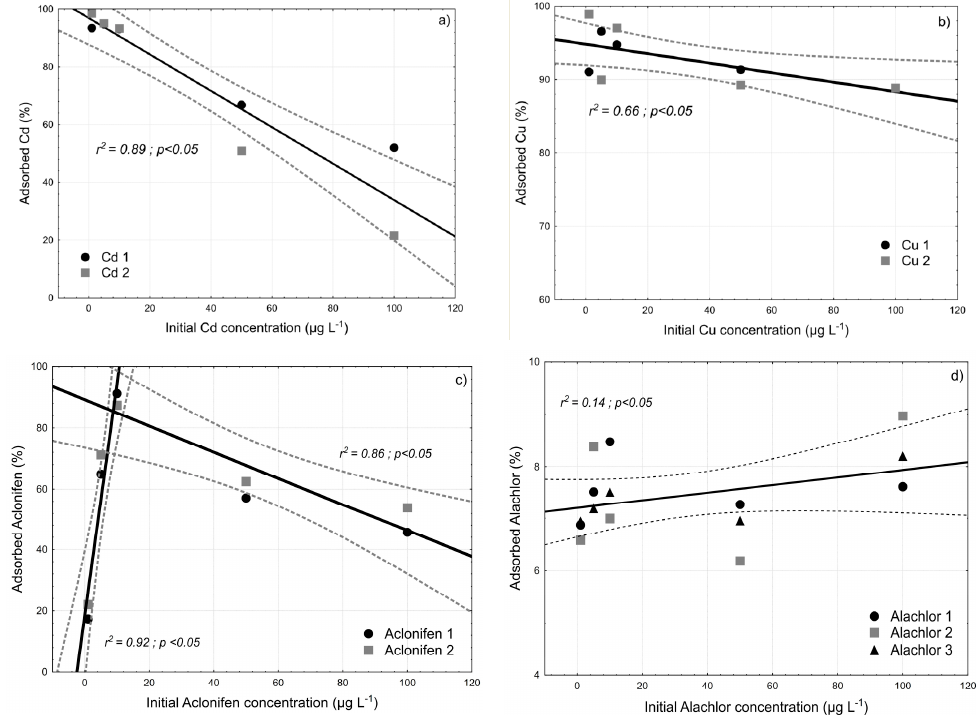
Figure 5. Adsorption percentage of Cd ( a ), Cu ( b ), Aclonifen ( c ) and Alachlor ( d ) as a function of the initial pollutant’s concentration. Linear regressions are presented with corresponding correlation coefficients. 1, 2 and 3 are duplicates. SPM Load is 1 g L − 1 .